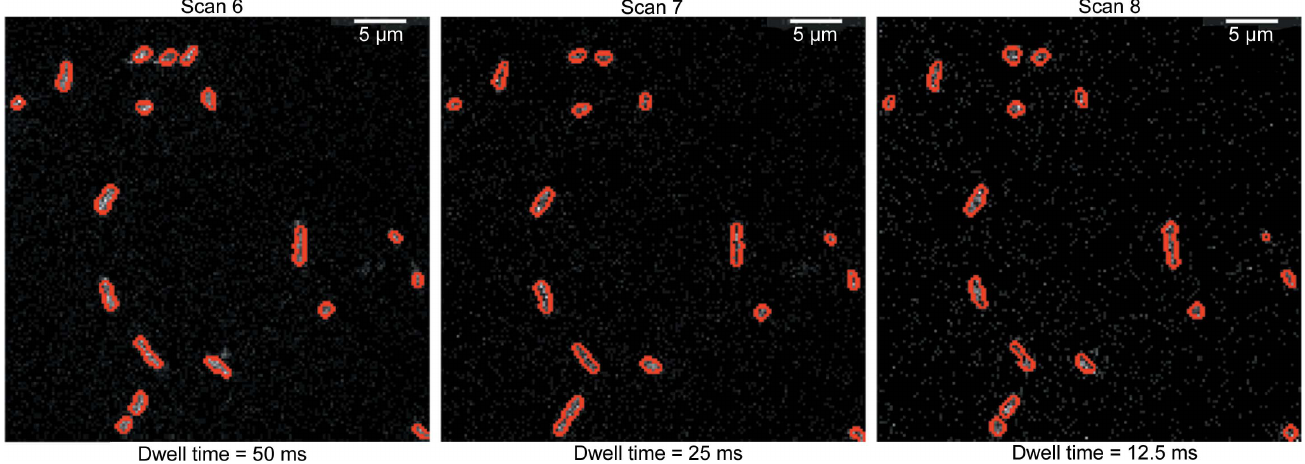
Figure 5 Segmentation masks of the coarse scans containing type C cells. Red indicates the boundary between the cell and background regions as detected by the segmentation scheme. Pixels inside the cells are labeled 1 and the background is labeled